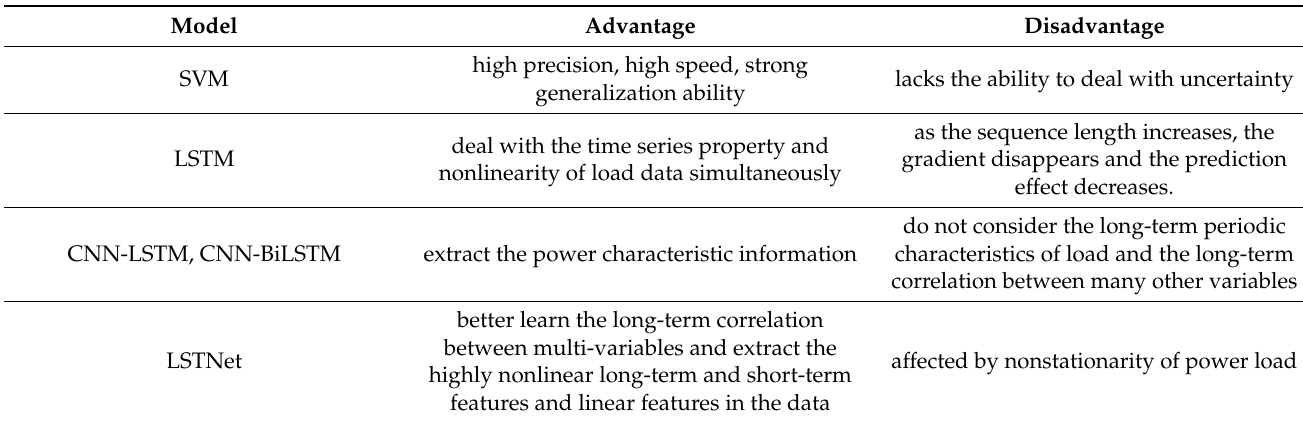
Table 1. Comparison of different power load forecasting models.